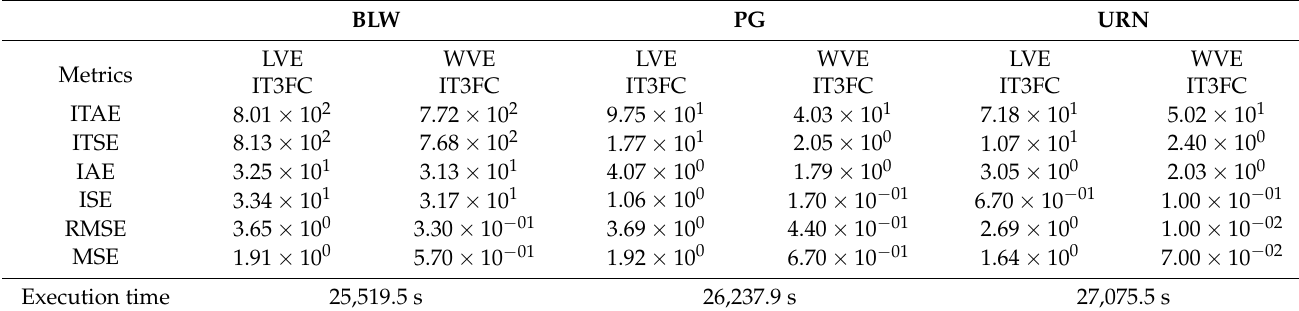
Table 7. Simulations obtained applying the BLW, PG, URN,